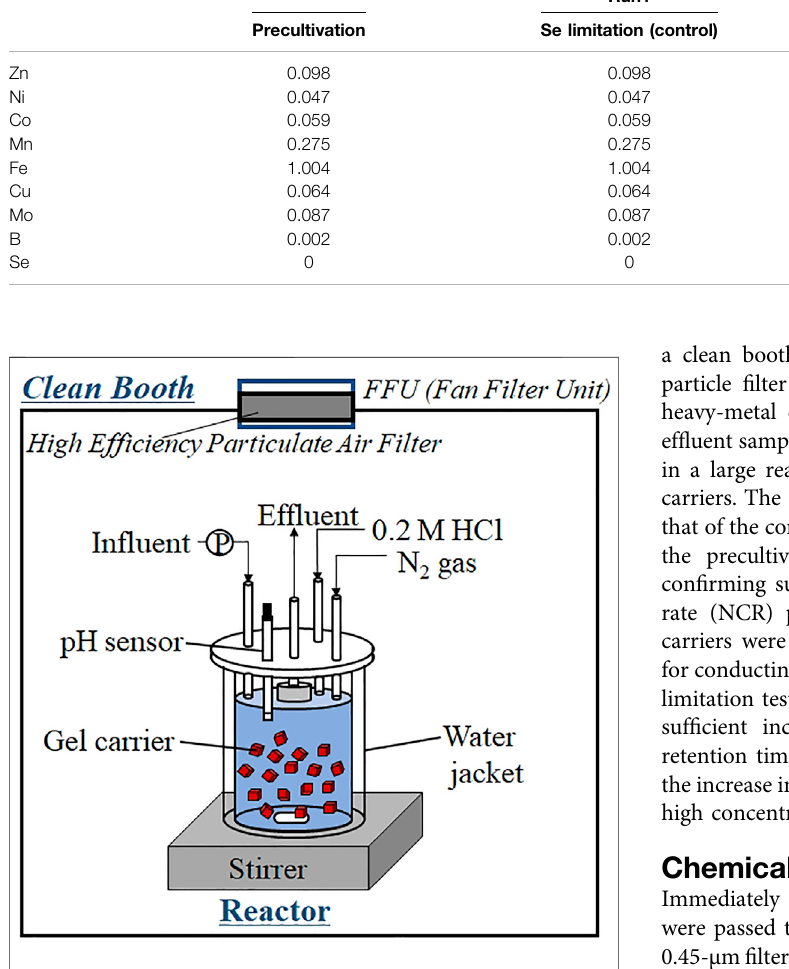
FIGURE 1 | Schematic of the continuous feeding reactor used in the trace-element limitation test. The reactor was set in a clean booth equipped with a fan fi lter